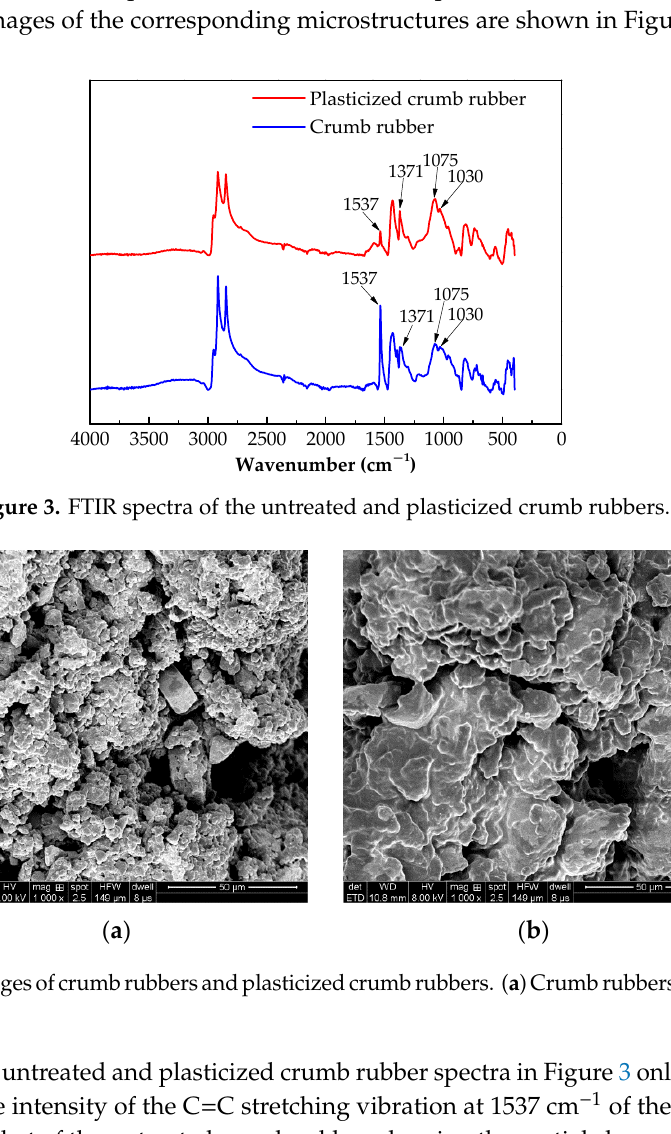
Figure 3. FTIR spectra of the untreated and plasticized crumb rubbers.